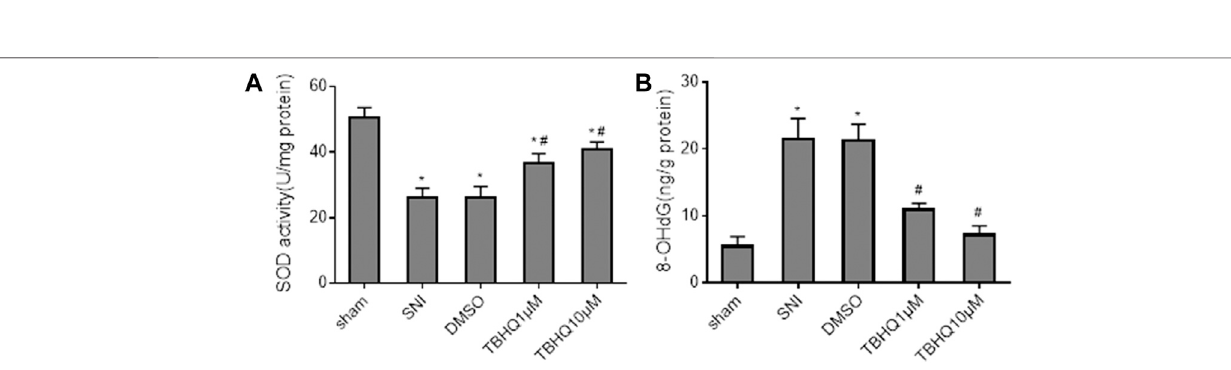
FIGURE 5 | Effects of intrathecal injection of DMSO or different doses of Nrf2 agonist tBHQ on levels of antioxidant enzyme superoxide dismutase (SOD, (A) and oxidativestress marker8-hydroxy-2 ′ -deoxyguanosine(8-OHdG, (B) in thespinal cord ofSNI rats. Sham ratswithout treatment served ascontrol.Values are expressed as mean ± SE (n (cid:1) 4 for each group). * p < 0.05 vs sham; # p < 0.05 vs SNI or